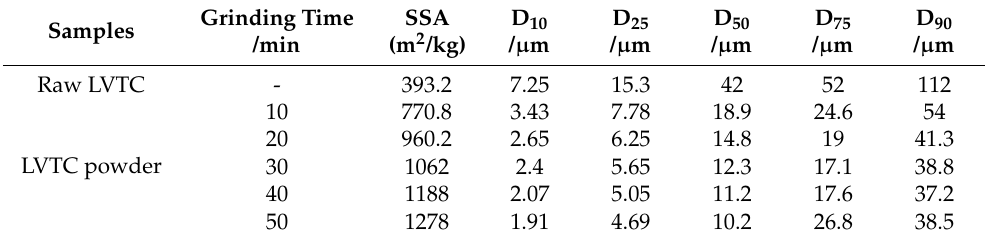
Table 5. SSA and EPS (D10, D25, D50, D75, and D90) of LVTC ground for different times.